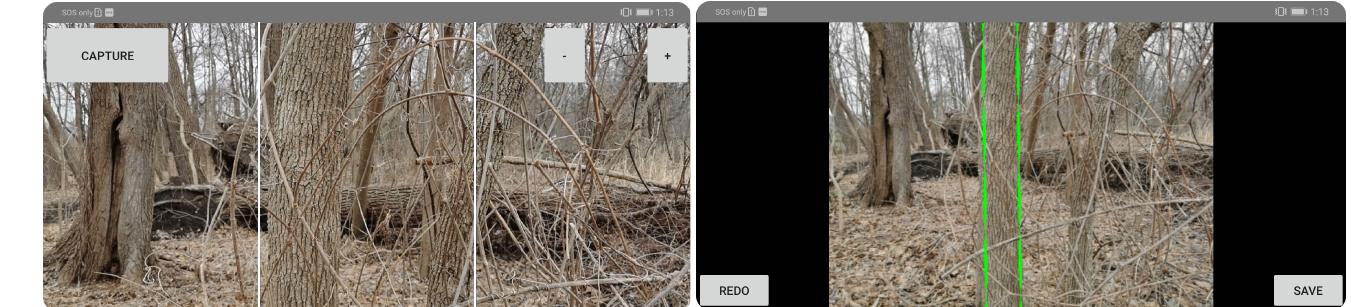
Figure 1. An intuitive and simple user interface facilitates rapid capturing and validation of collected data. ( Left ) The app display shows the main camera preview. White lines help the user to center the tree in the frame. The ‘Capture’ button saves the current frame and initiates the image processing algorithm. ( Right ) After clicking ‘Capture’, the app highlights in green the detected trunk boundaries from which it will estimate diameter. The user is prompted to ‘Save’ the image, or else ‘Redo’ if the algorithm does not appear to have captured the tree